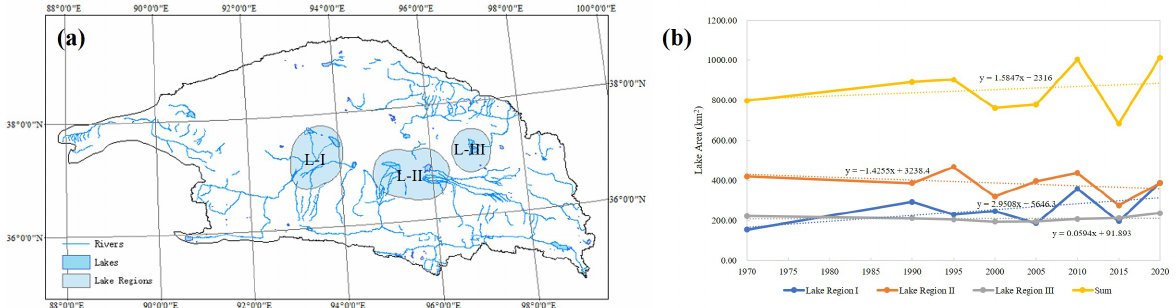
Figure 6. ( a ) Three representative lake-climate regions (L-I, L-II, L-III) identified by the fine-grained climate classification and ( b ) their lake area variations with linear trends shown by the dotted lines in the corresponding colors (1970 to 2020).